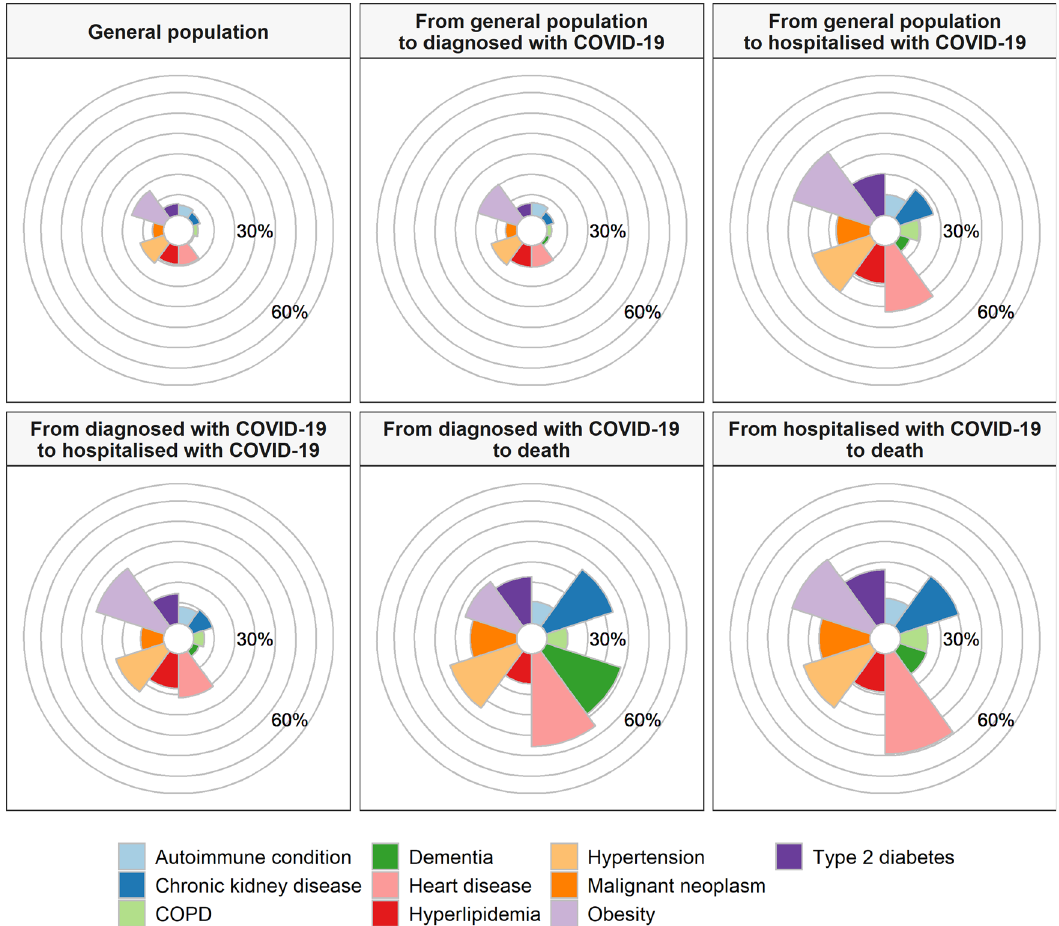
Fig. 3 Prevalence of comorbidities among the general population and by transition in the multistate model. The proportion of the study population as a whole (general population) with a comorbidity of interest, and of those individuals making transition from general population to diagnosed with COVID-19 and hospitalised with COVID-19, from diagnosed with COVID-19 to hospitalised with COVID-19 and death, and from hospitalised with COVID-19 to death. COPD chronic obstructive pulmonary